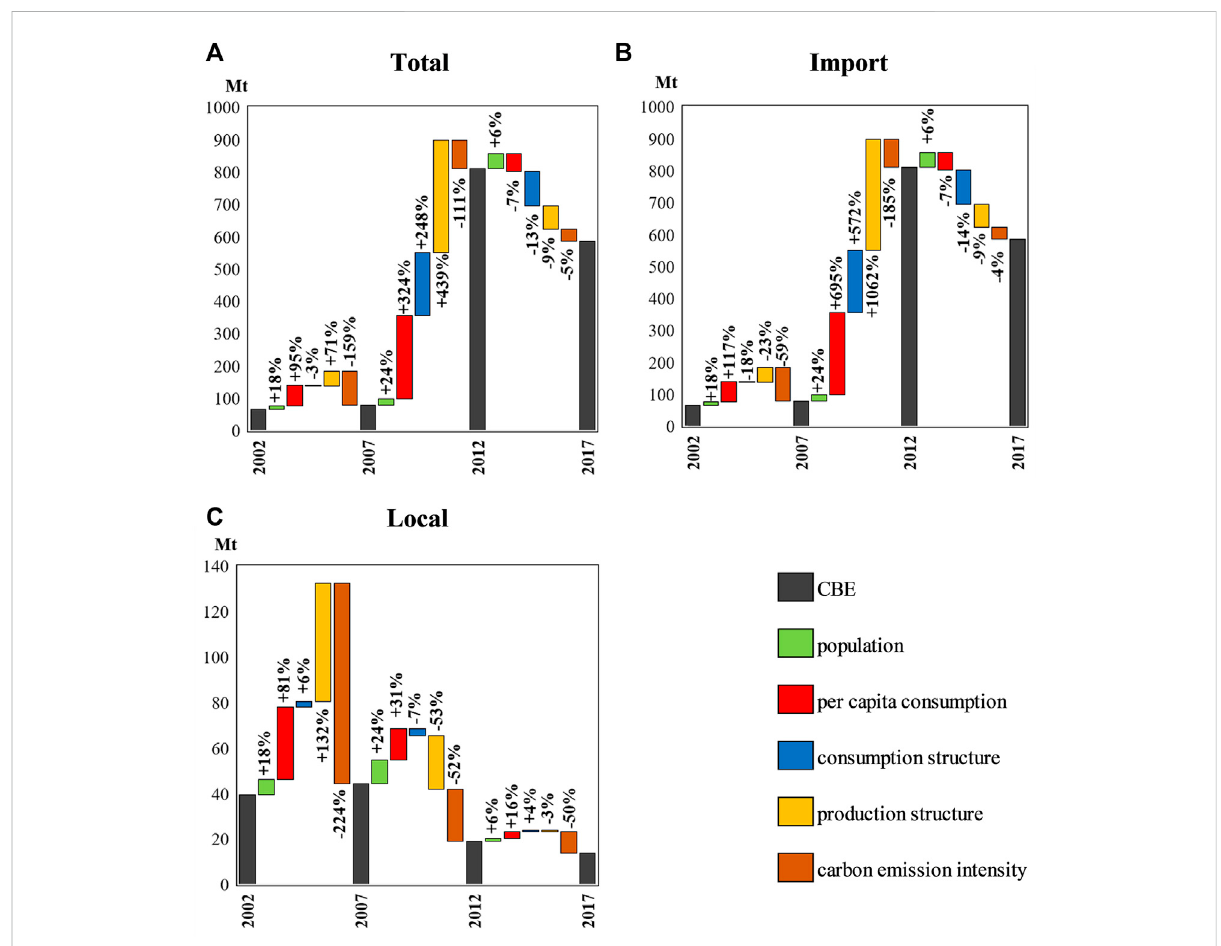
FIGURE 9 Contribution of socioeconomic factors to the change in (A) total consumption-based carbon emissions, and decomposed into (B) import and (C) local